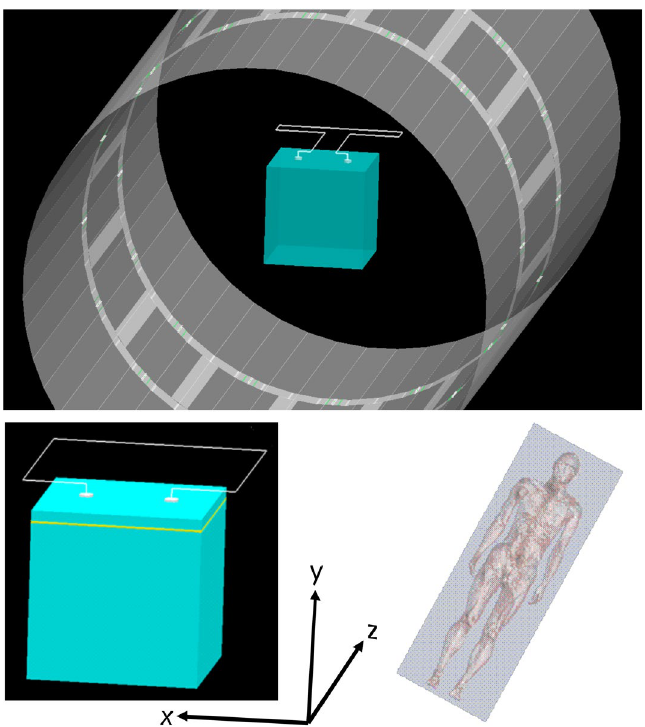
Figure 8. Simulation of the head phantom in MRI with leads. Small area and large area version with insulation layer (yellow). The coordinate system is intended to illustrate how the phantom is oriented in the scanner. The z direction represents the head-foot